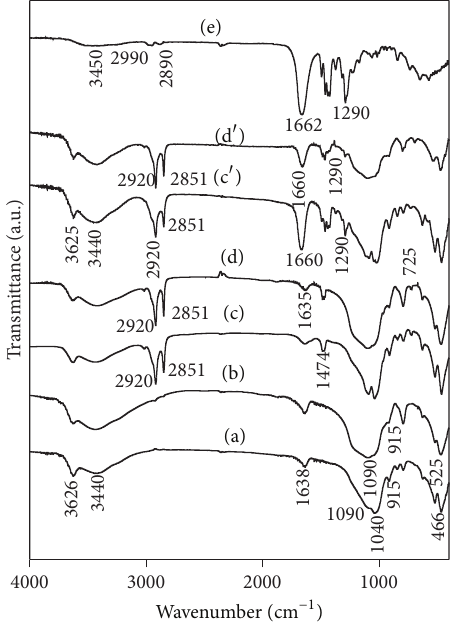
Figure 2: FTIR spectra of (a) Mt, (b) AMt0.5, (c) C16TMA-Mt, (d) C16TMA-AMt0.5 (c 󸀠 ) PVP/C16TMA-Mt, and (d 󸀠 ) PVP/C16TMA- AMt0.5. (e) The FTIR spectrum of neat PVP was presented for